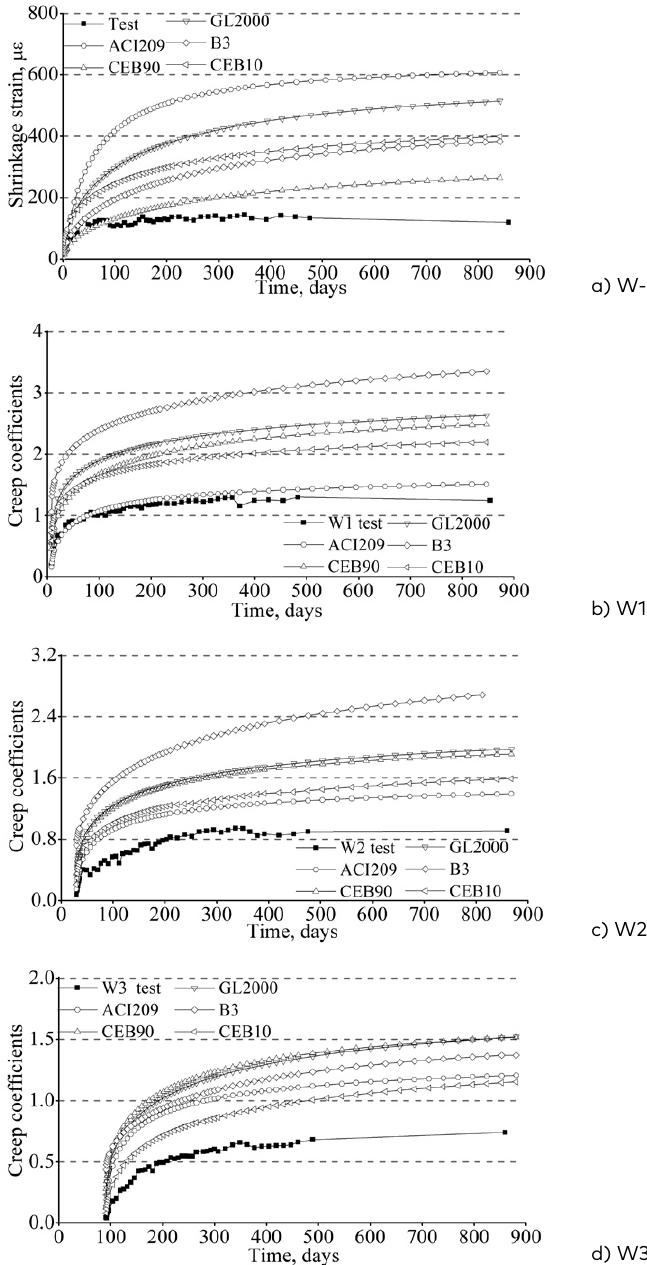
Figure 8. Comparison of experimental and predicted results for C60